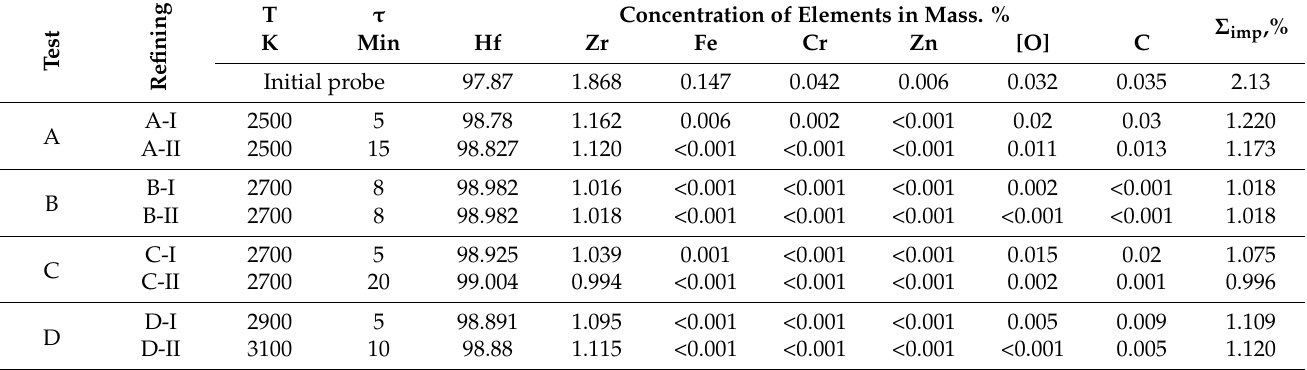
Table 3. Process parameters and chemical composition of ingots before EBM and after double e-beam refining of technogenic hafnium.